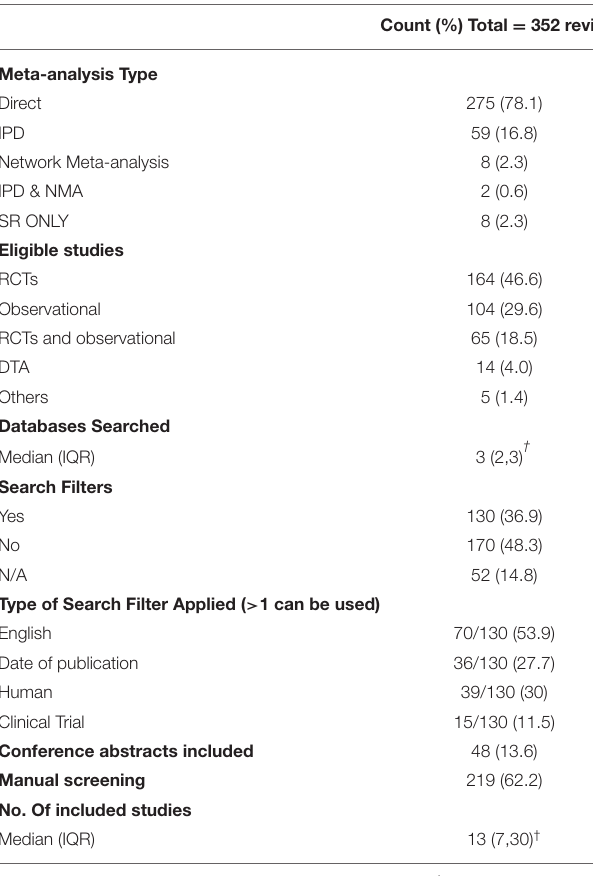
TABLE 1 | Characteristics and literature search methods of the assessed systematic reviews in the current analysis.